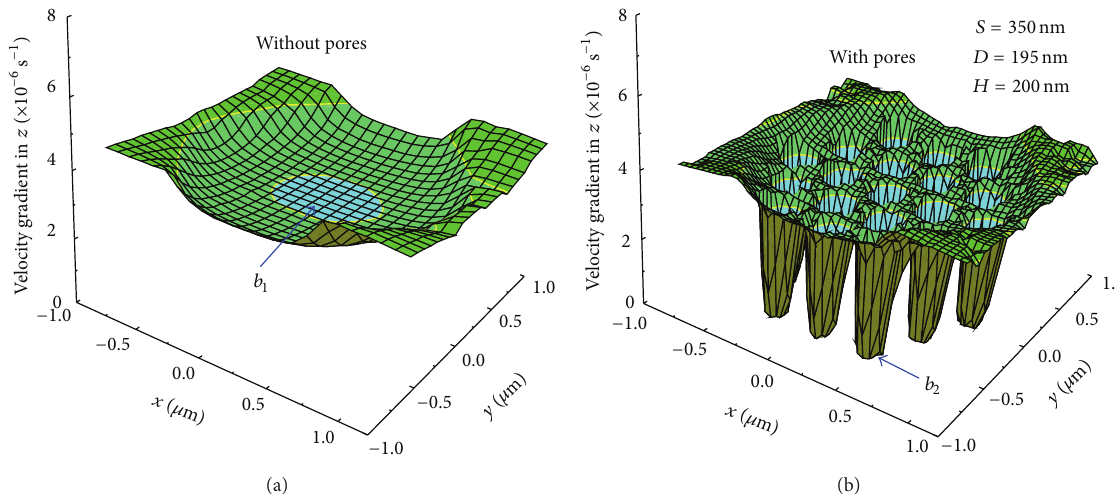
Figure 7: Velocity gradients of Coscinodiscus sp. frustules with and without pores: (a) without pores and (b) with pores. 8.09.511.012.514.0